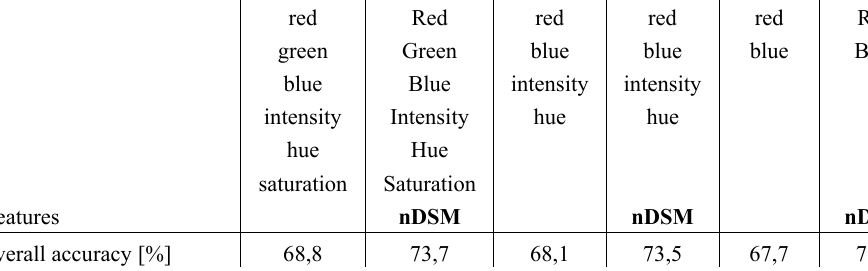
Table 1: Classification results for different amounts of features, each case with and without nDSM